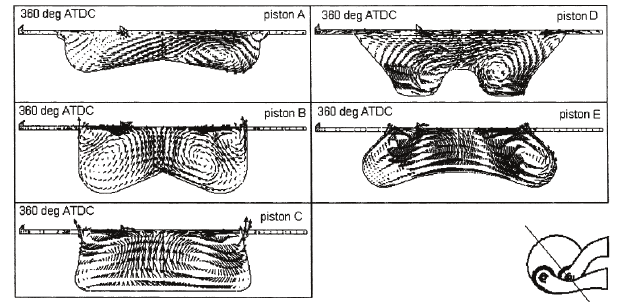
Fig. 10. Vectors of speed at TDC for 5 types of combustion chamber [9]